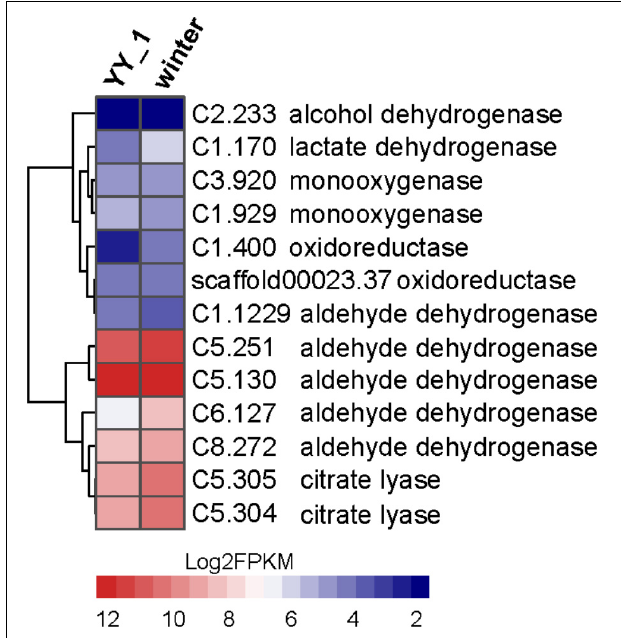
FIGURE 7 | Expression levels of the genes involved in acetyl-CoA biosynthesis in the M. purpureus winter and YY-1 strains. The tree is a dendrogram of the cluster analysis obtained by the hclust method in R , which is a hierarchical partitioning of data that visually resembles a heat map and reflects the gene expression values in different